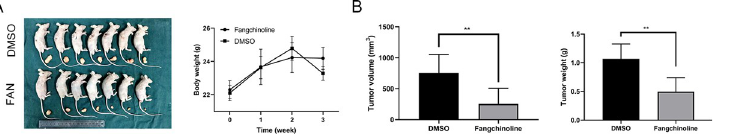
Fig 4. Fangchinoline suppresses the oncogenesis of GBC-SD cells in vivo. (A) The photograph of nude mice and xenograft tumors. (B) The volume and weight of xenograft tumors were measured. �� P < 0.01, compared with the DMSO